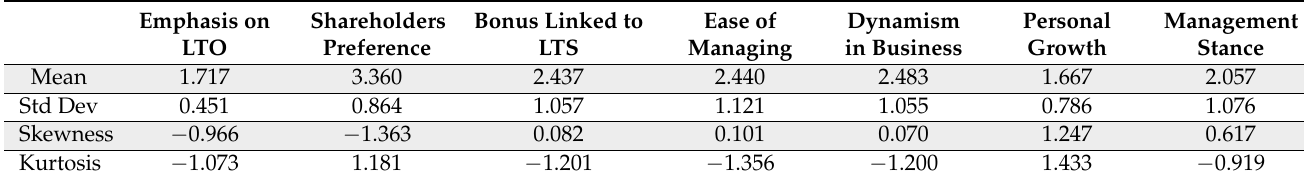
Table 2. Impact factors in